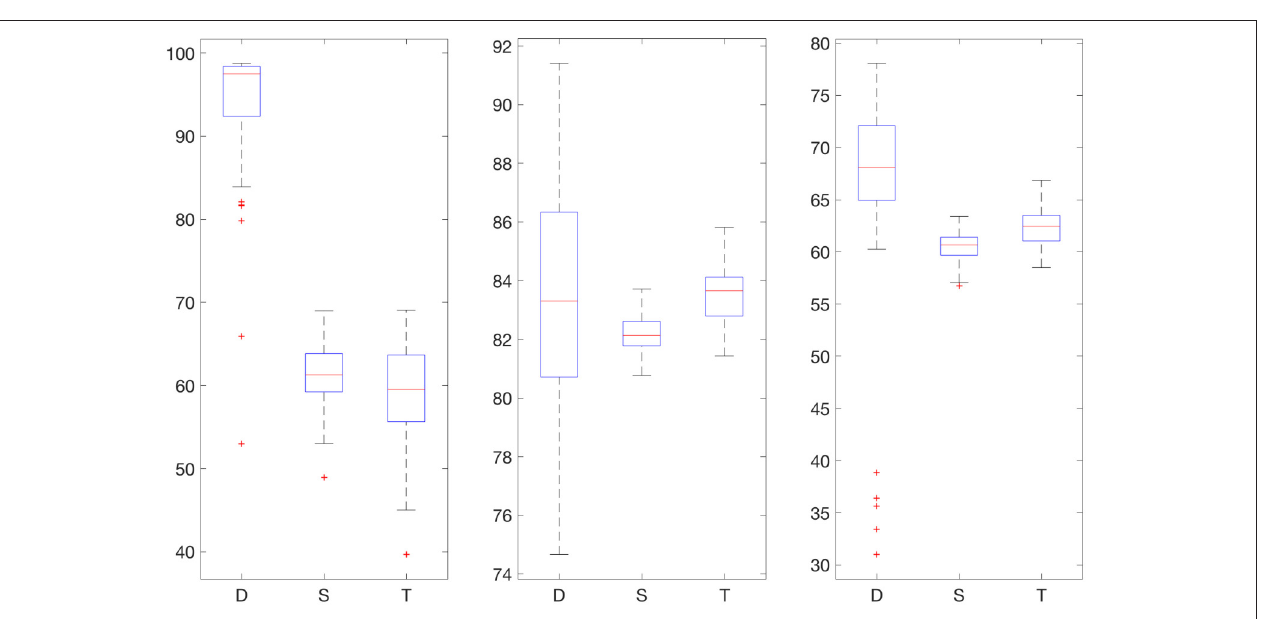
FIGURE 5 | Boxplot for the 100 experiments conducted with flat low-pass filtering and 50% training data for each prediction method (D, deep network; S, shallow network; T, Tikhonov regularization). The three graphs show the percentage accurate predictions in the hypoglycemic range (left), euglycemic range (middle) and hyperglycemic range